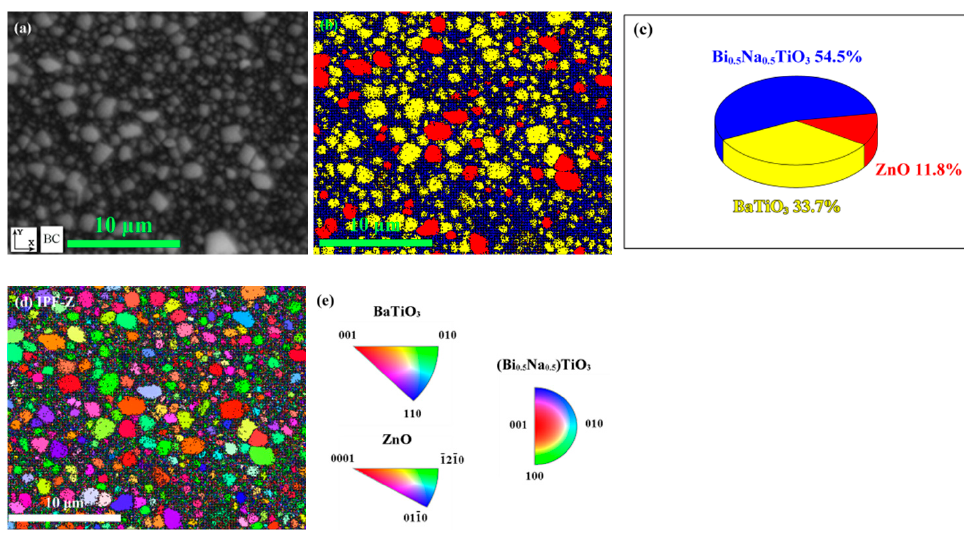
Figure 10. ( a ) Surface morphology of EBSD scanning region in the component x = 0.3, ( b ) phase distribution in the selected region, ( c ) percentage of different phases in the scanning region, ( d ) crystal orientation map along Z axis, and ( e ) inverse pole figure (IPF) color key.